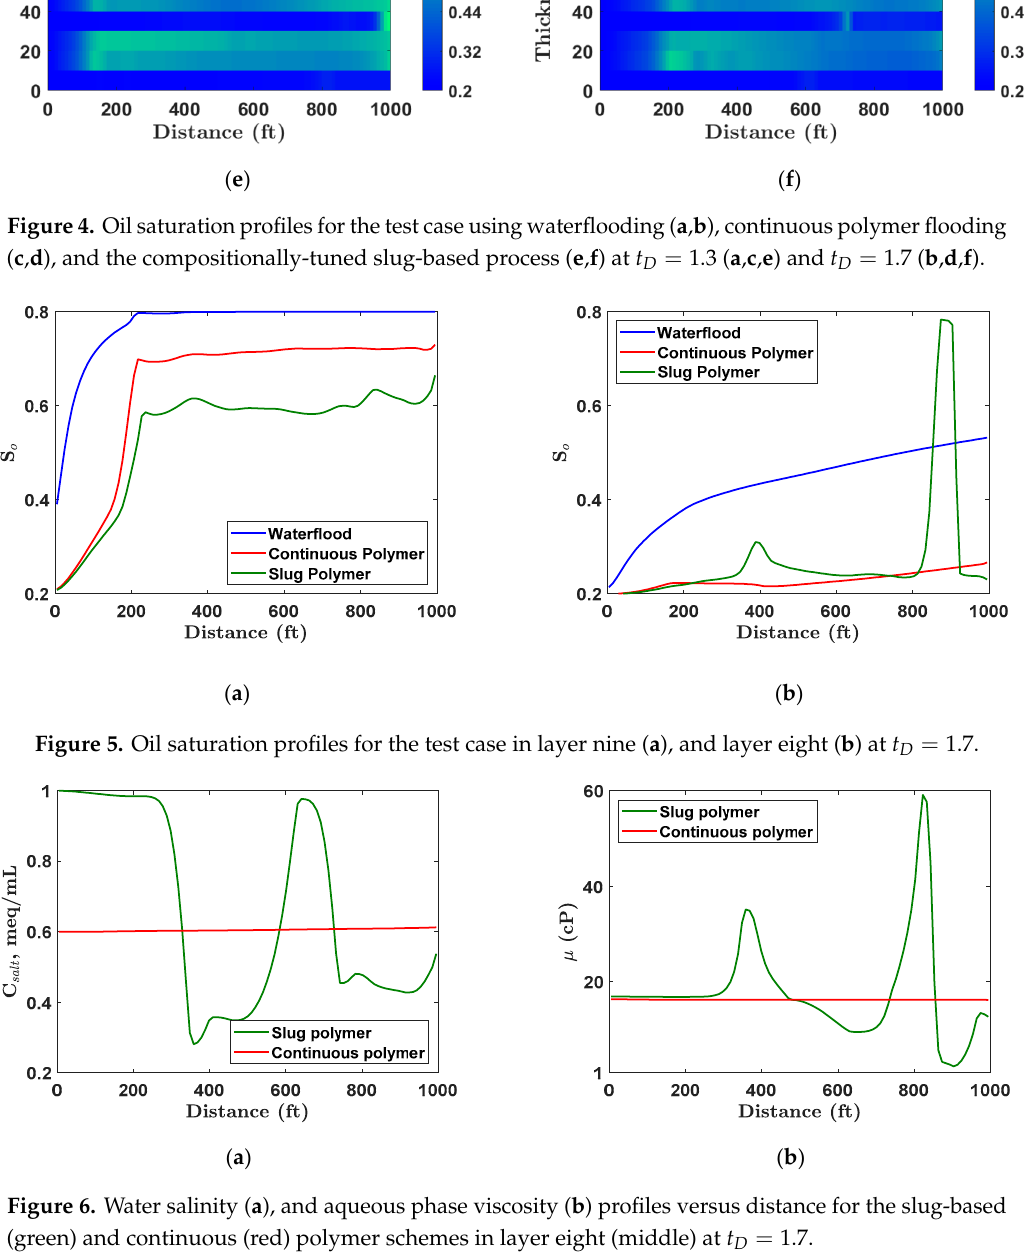
( d ) ( e ) ( f ) Figure 7. Polymer concentration in wt.% ( a , b ), salinity ( c , d ), and aqueous phase viscosity ( e , f ) profiles for the test case using the compositionally-tuned slug-based process at 1.3 D t = ( a , c , e ) and 1.7 D t = ( b , d , f ).